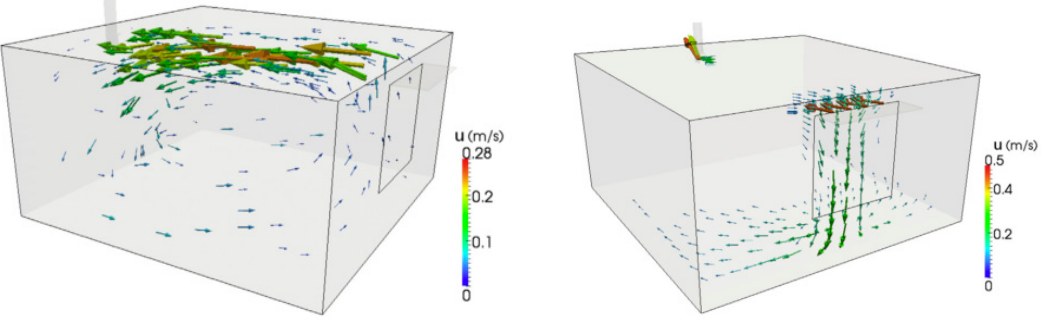
◦ C ( left ); − 10 ◦ C ( right ) Figure 20. Air inlet with 19 °C ( left ); − 10 °C ( right ) [77]. Figure 20. Air inlet with 19 Figure 20. Air inlet with 19 °C ( left ); − 10 °C ( right ) [77].